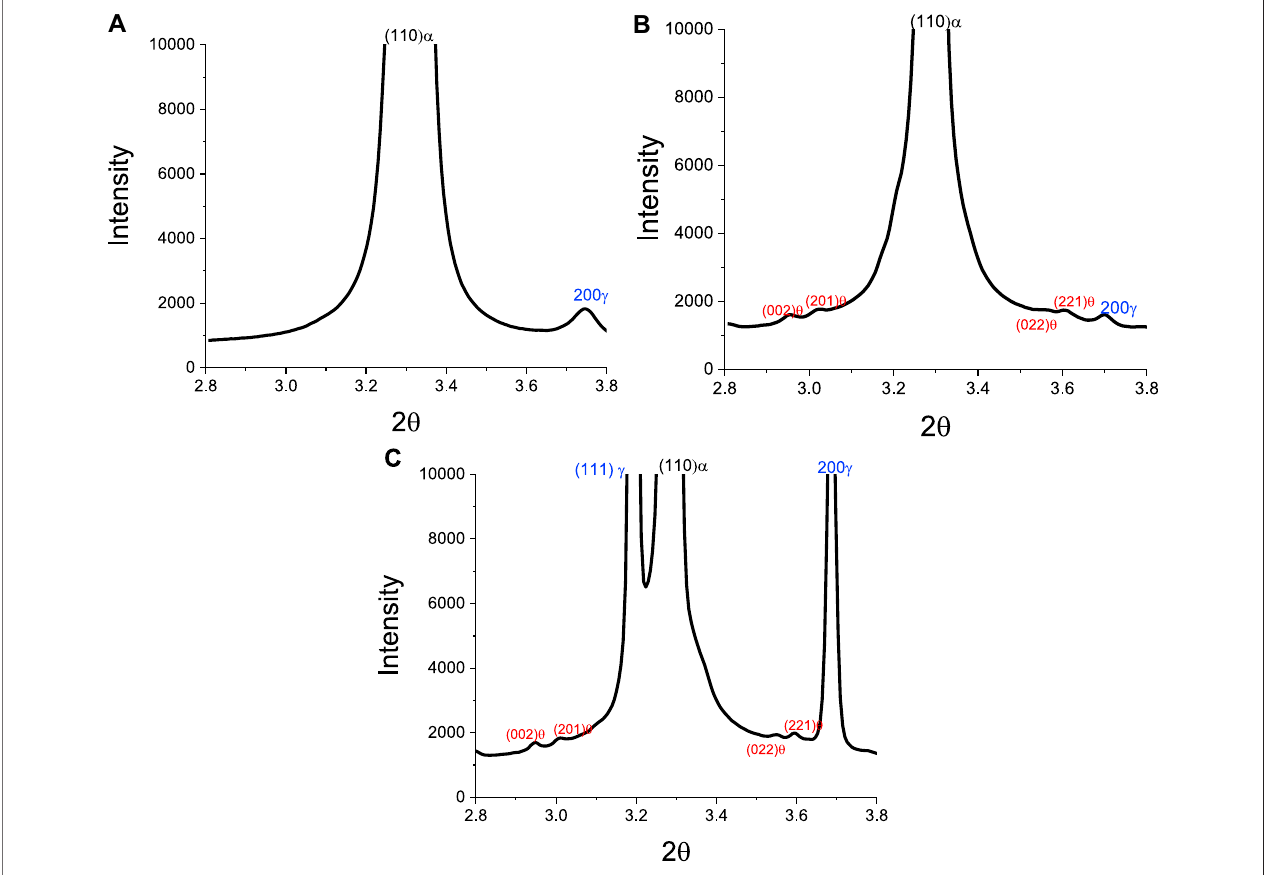
FIGURE6 | HEXRD diffraction spectrafor a sample at selected stages in the ICA thermal cycle: (A) before heating, (B) after heatingto 375 ° C, and (C) after holding for 25 min at 650 ° C.